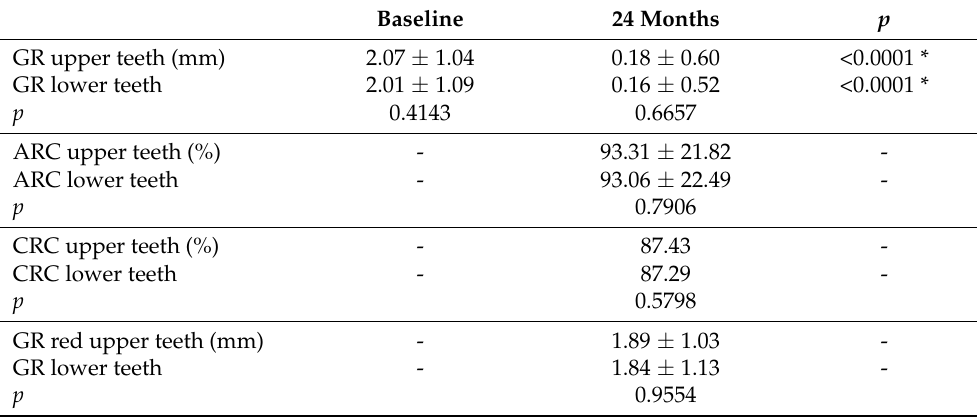
Table 2. Clinical parameters (mean and standard deviation) at baseline and 24 months after